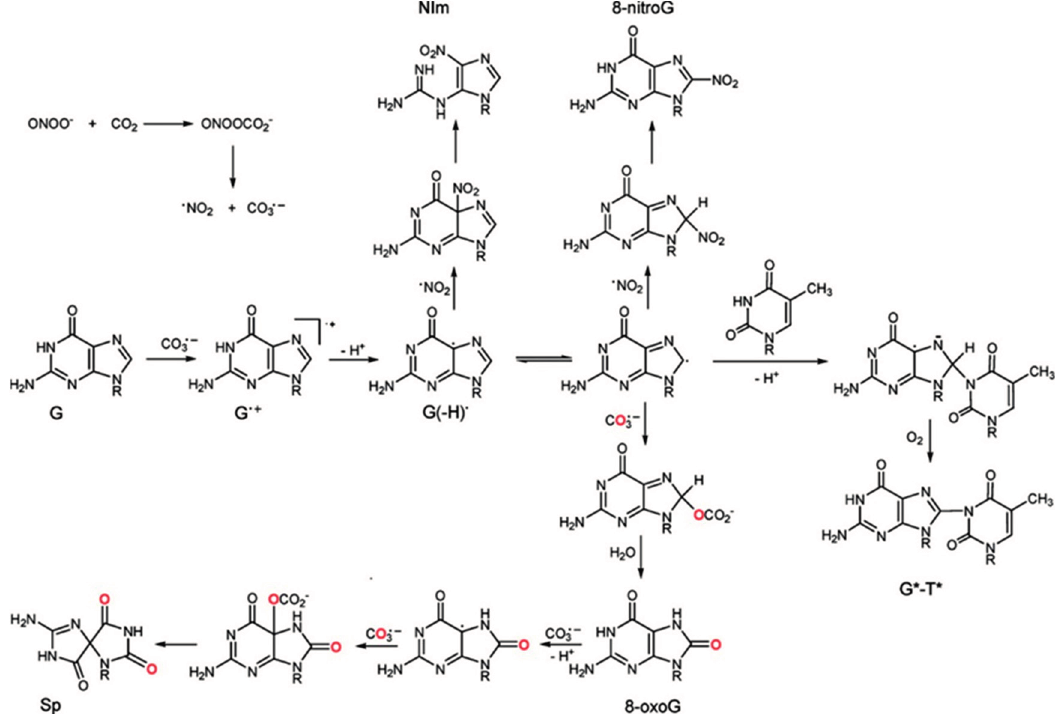
Figure 3. Lesion derived from the oxidation of guanine in DNA by decomposition products of nitrosoperoxycarbonate (CO 3 ●− and ● NO 2 ). Adapted from [127] with the permission of the American Chemical Society,